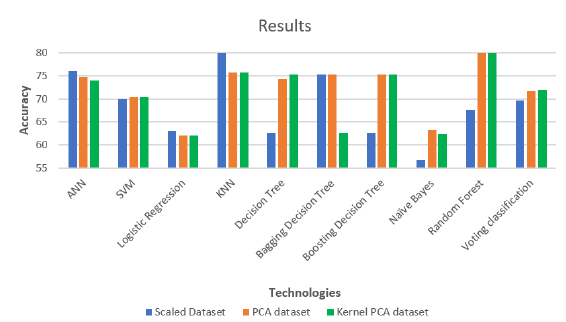
Figure 10. Technologies vs Accuracy